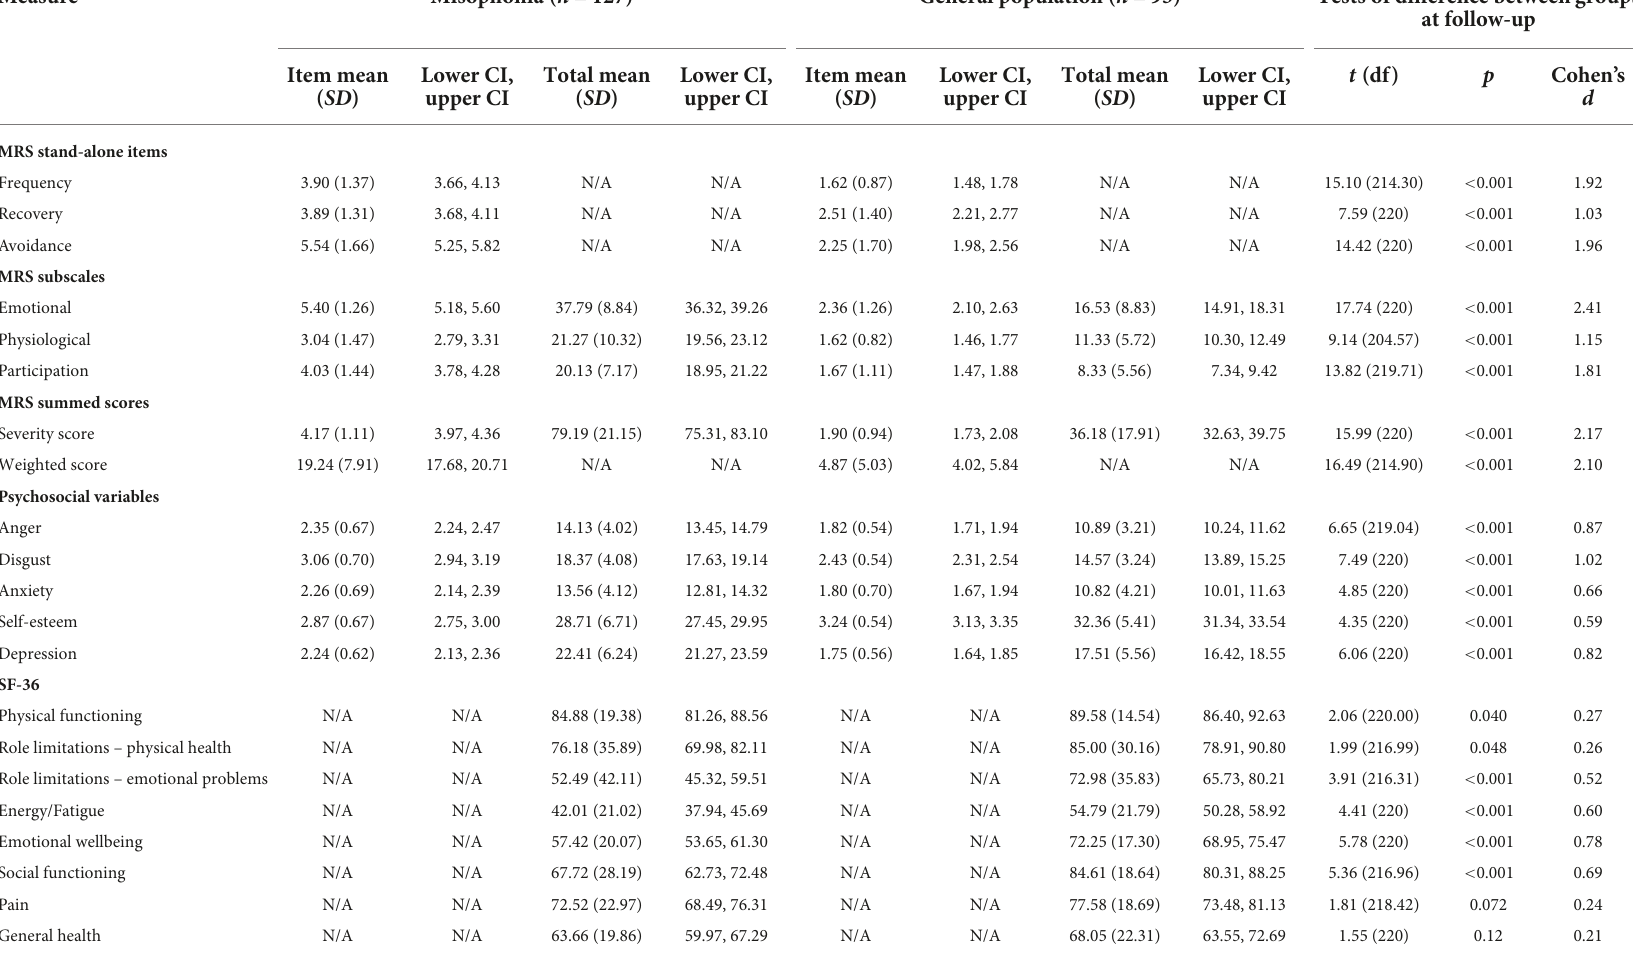
TABLE 6 Descriptive statistics and between-group tests of difference for misophonic responses, psychosocial variables, and quality of life at follow-up.